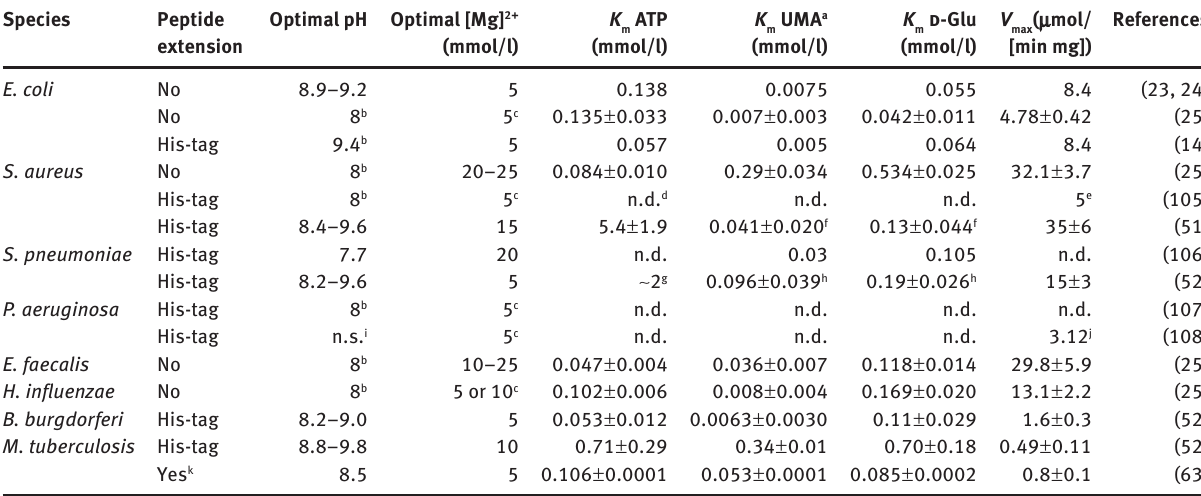
Table 1 Optimal pH, optimal Mg 2+ concentration, and kinetic parameters of MurD orthologs.